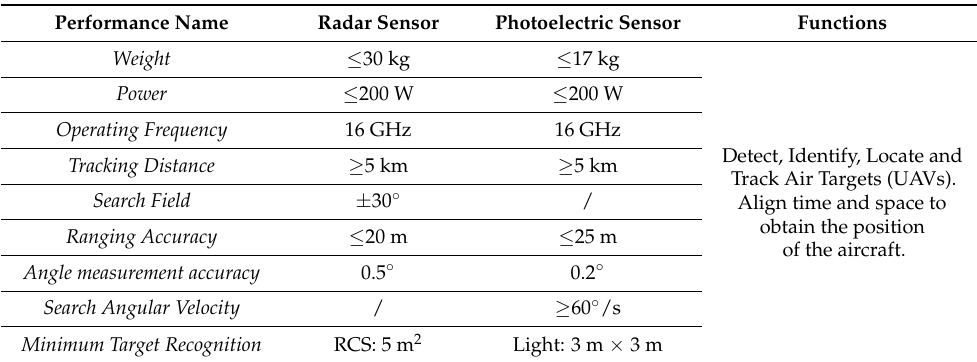
Table 4. The performance of sensors carried by